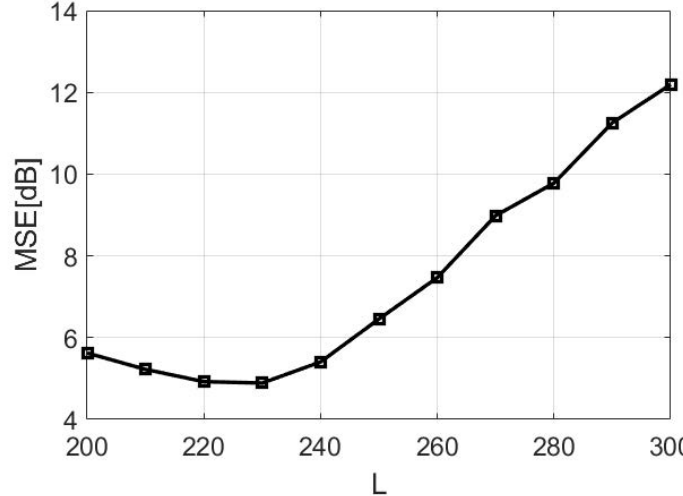
Figure 12. Performance of different L in KL algorithm.